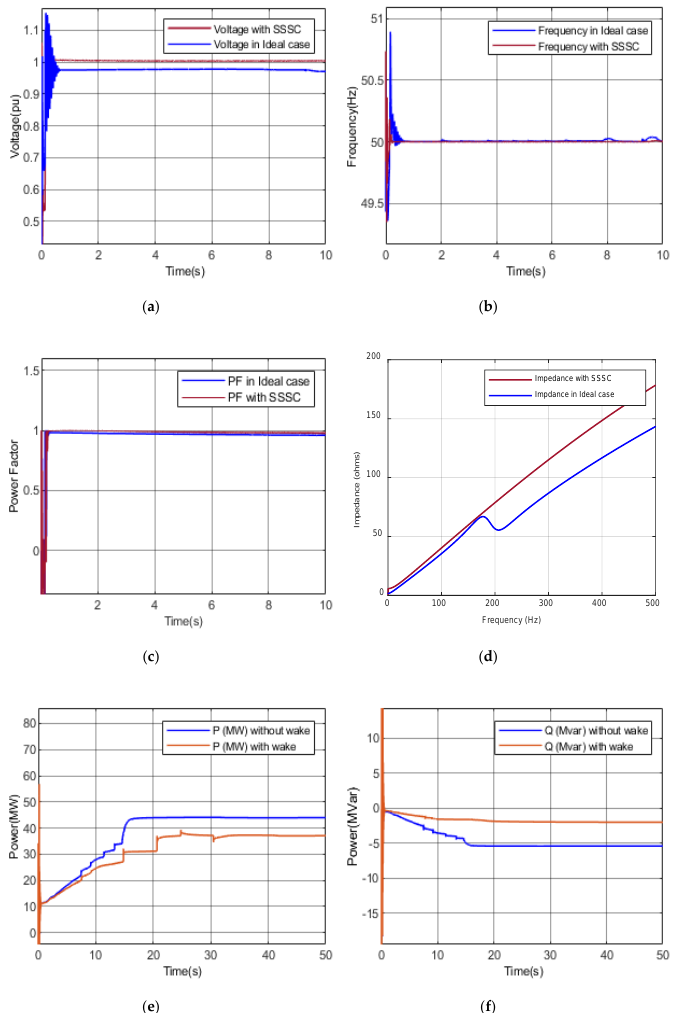
Figure 12. Case-2, Scenario 9: ( a ) Voltage (V) at PCC; ( b ) Frequency (F) at PCC; ( c ) PF at PCC; ( d ) Impedance (Z) vs. F; ( e ) P-trend; ( f )